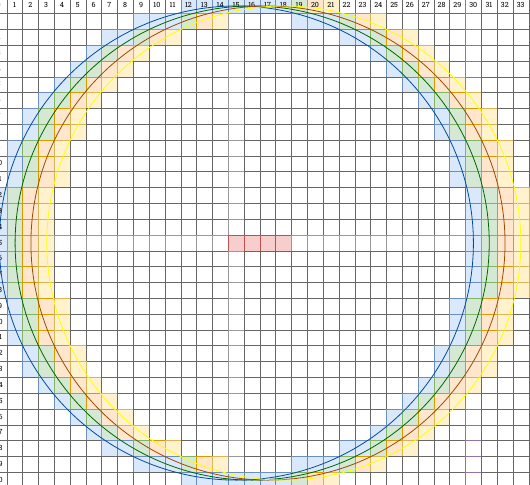
Figure 8. Schematic representation of the pixels included in the four consecutive contexts of 31 × 31 px. The coloured Bresenham circles mark the circular sections that we use to compute the image moments. In red we indicate the consecutive centres of the circles (the points under